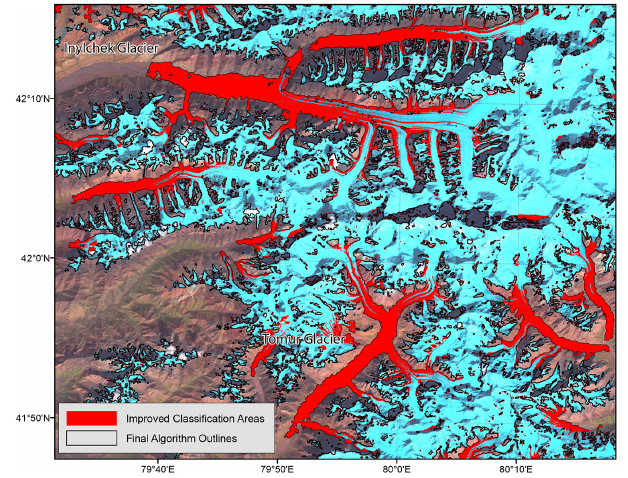
Figure 3. Final algorithm outlines (black) with areas classified in addition to the clean-ice delineation in red. Landsat OLI image cap- tured on 25 September 2013 as